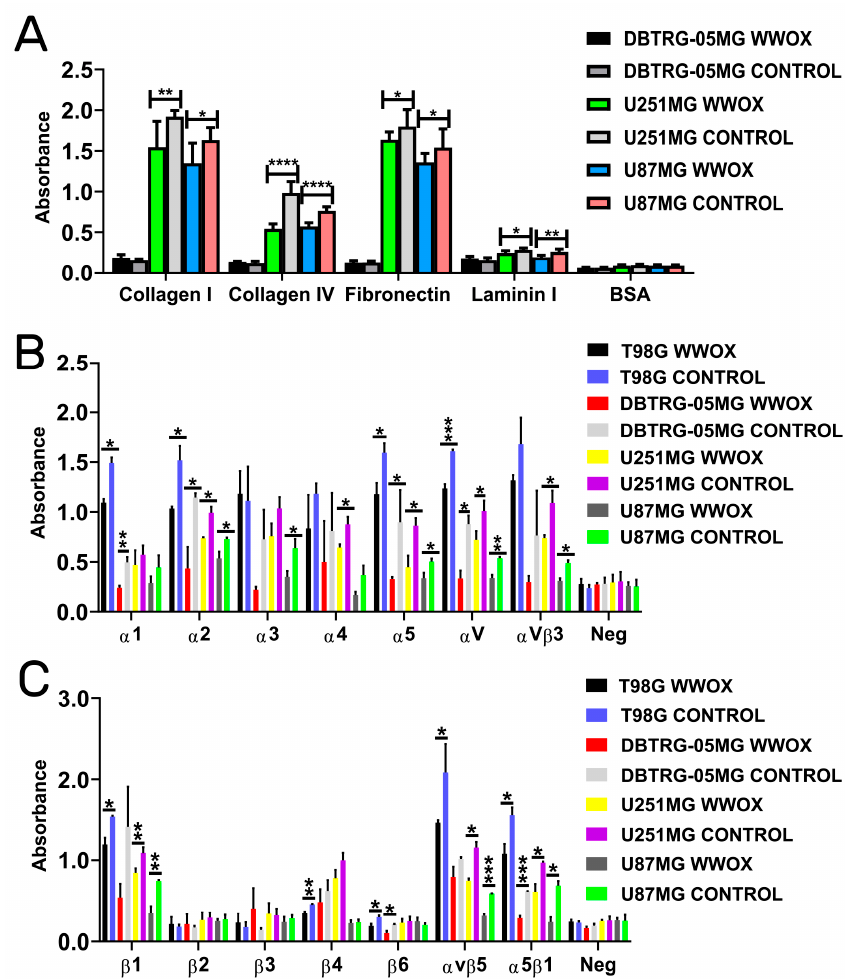
Figure 3. Adhesiveness to ECM proteins together with panels of α and β integrins. ( A ) Adhesion to ECM proteins. BSA—negative control. ( B ) α -subunits of integrins. Neg—negative control. ( C ) β -subunits of integrins. Neg—negative control. p < 0.05 (*), p < 0.01 (**), p < 0.001 (***), p < 0.0001 (****).